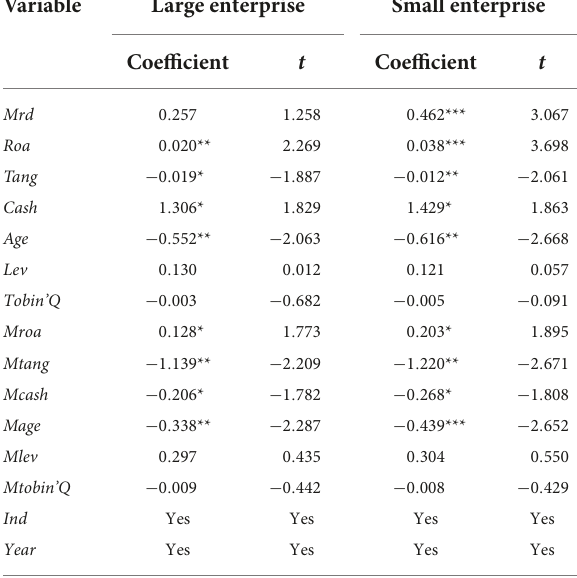
TABLE 5 Subsample grouping regression results with different enterprise